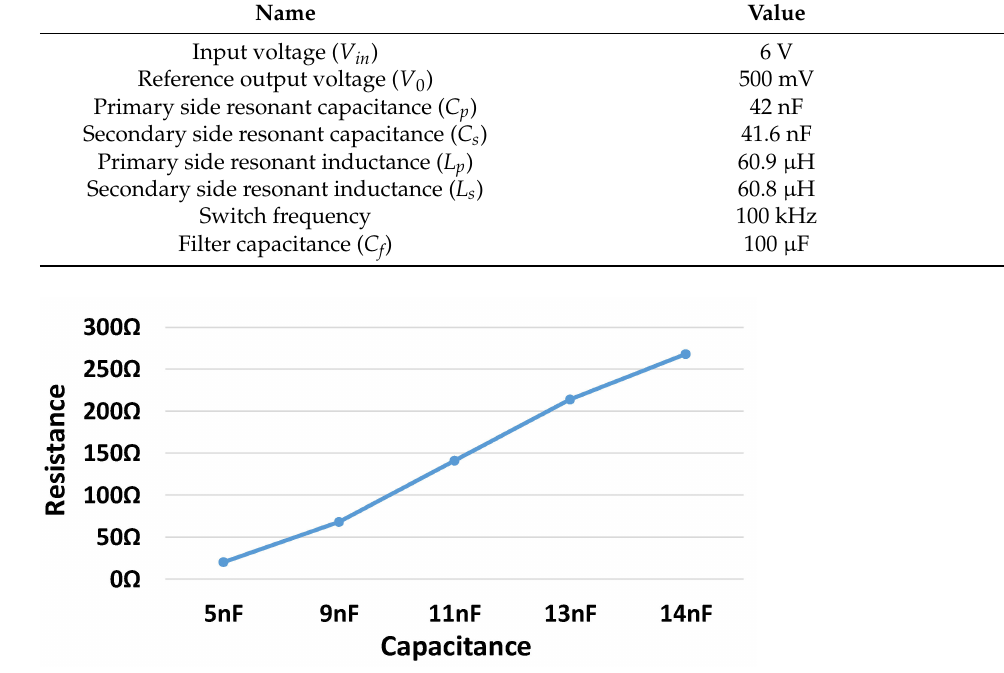
Figure 27. The curve of the maximum value of the load resistance, after five groups of auxiliary capacitors are connected in parallel.